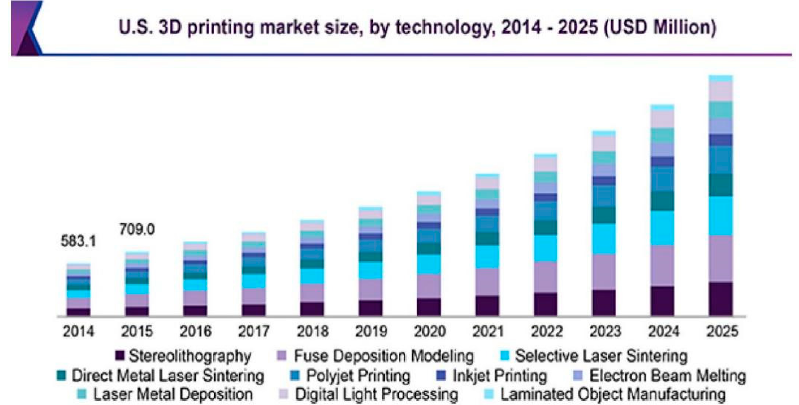
Figure 15. Market survey of the increase in the printing technology for US market for years from 2014 to 2025. Reproduced from 3D-printing market size, share, and trends analysis